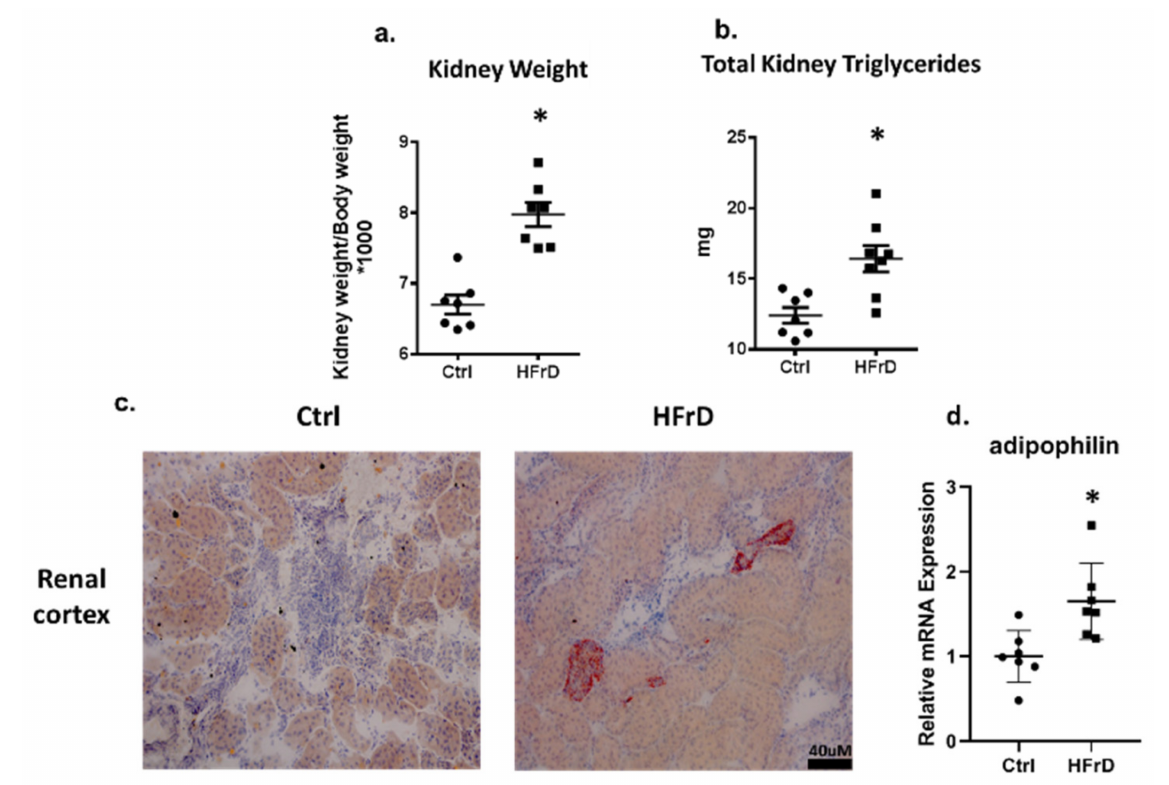
Figure 2. HFrD increased kidney weight and induced ectopic lipid accumulation in the kidneys. Kid- ney weight was measured at the end of the study and was normalized to body weight ( a ). Total kidney triglycerides were measured using a colorimetric Assay Kit ( b ). Ectopic lipid accumulation was measured by oil red O staining in the renal cortex, representative slides, and 20 × magnification ( c ). Kidney adipophilin expression levels were measured by real time PCR ( d ). * p ≤ 0.05. n =